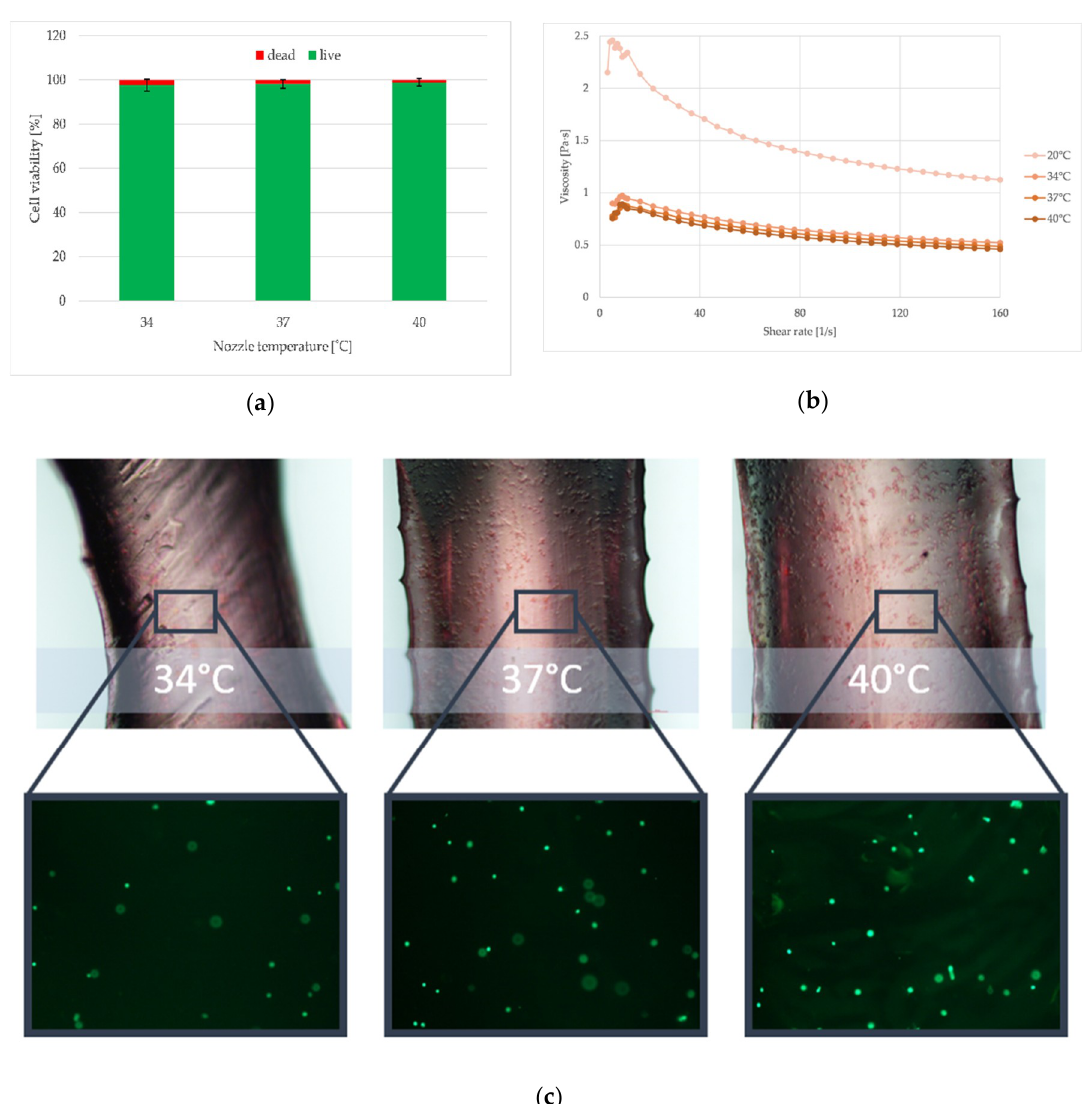
Figure 10. Influence of different temperatures of extrusion (34, 37, and 40 °C) on the endothelial cells (EA.hy 926 line) viability ( a ), viscosity ( b ), and path width ( c ) of the 5A4GM hydrogel. Photomicroscopy, 100x magnification, fluorescence microscopy, 50x magnification.